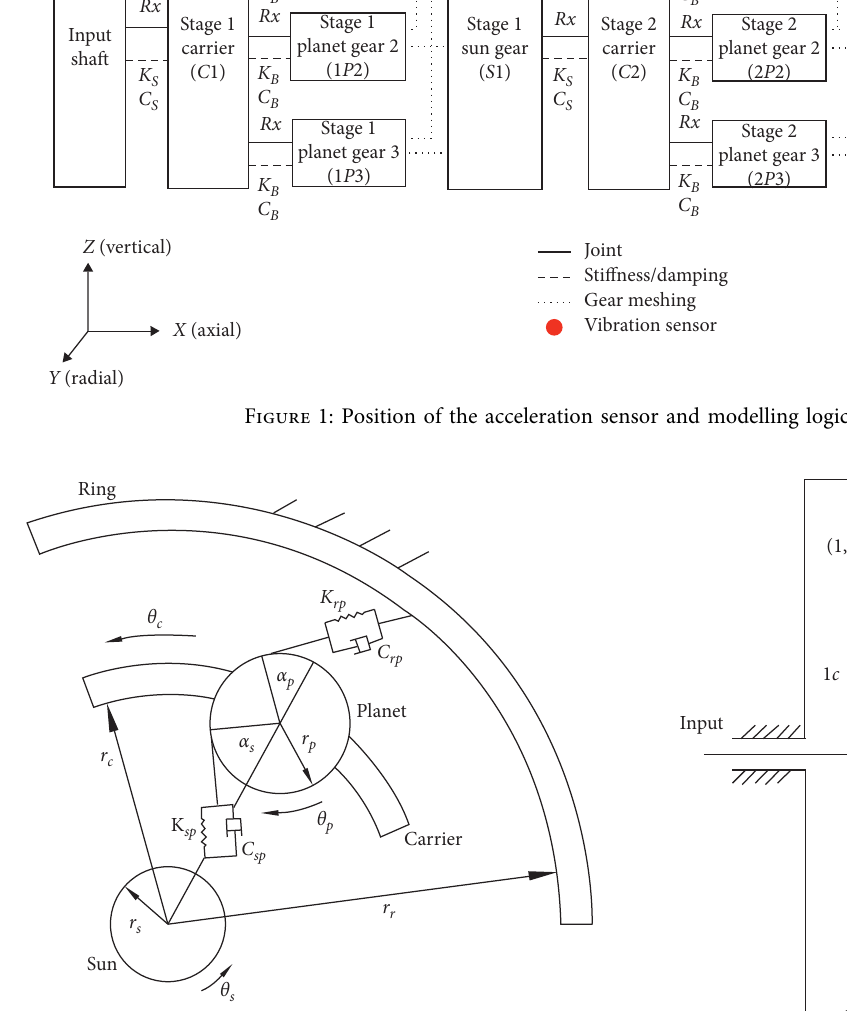
Figure 2: Analytical modelling of the planetary gear system [21].